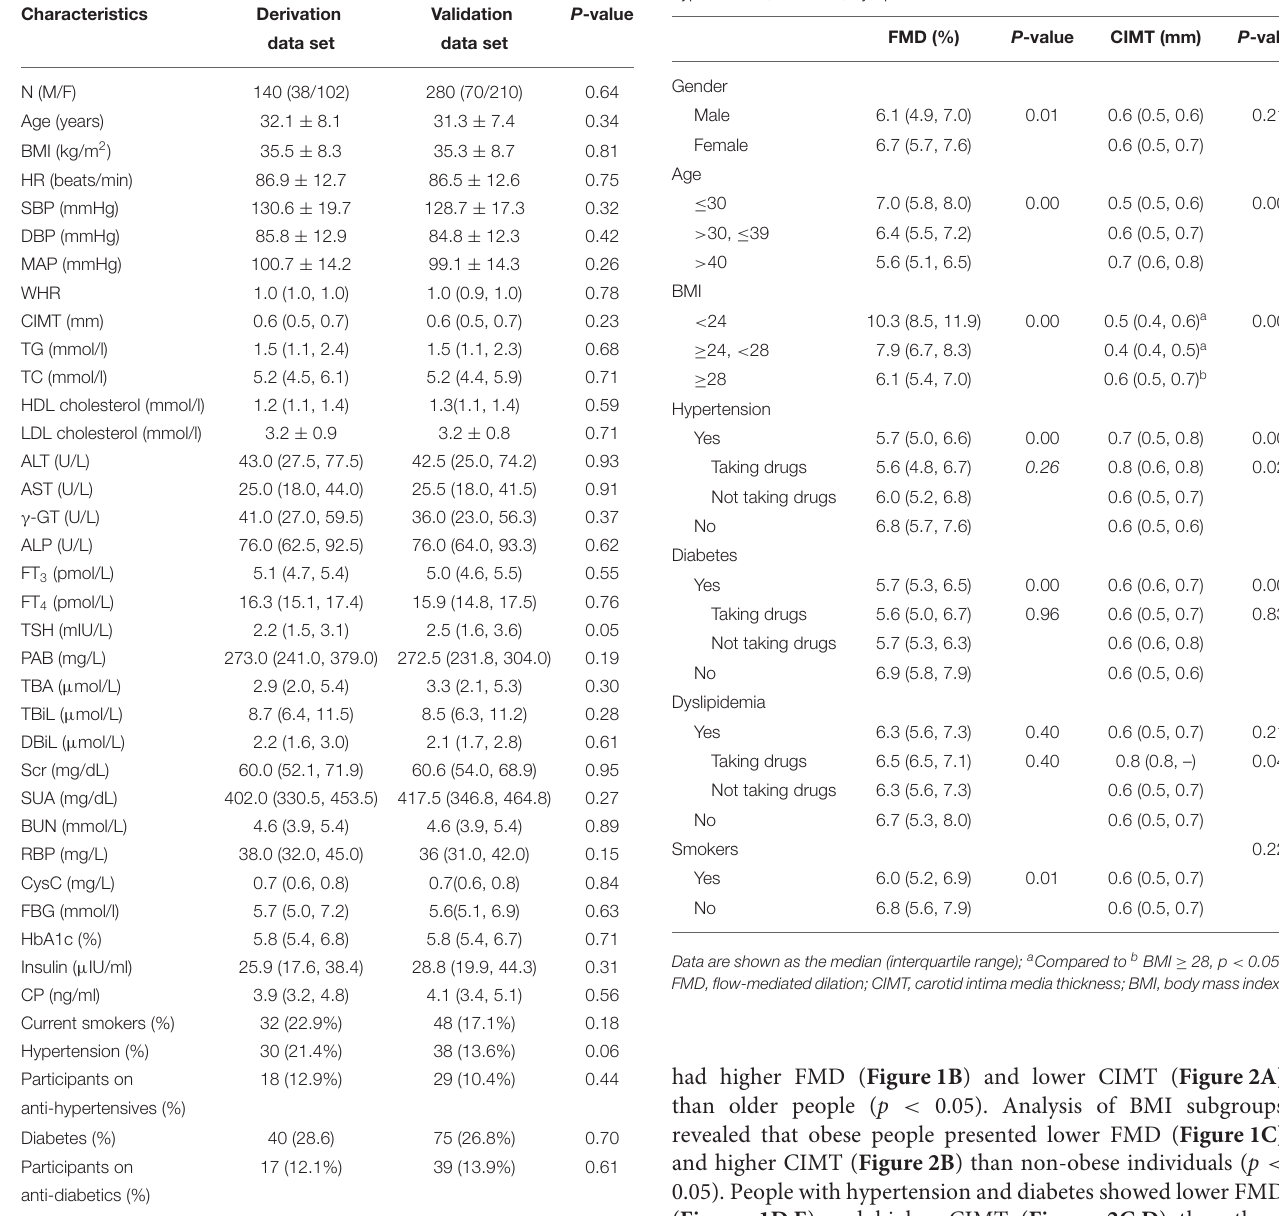
TABLE 1 | Characteristics in the derivation and validation cohorts. TABLE 2 | Values of FMD and CIMT in subgroups of gender, age, BMI, hypertension, diabetes, dyslipidemia and